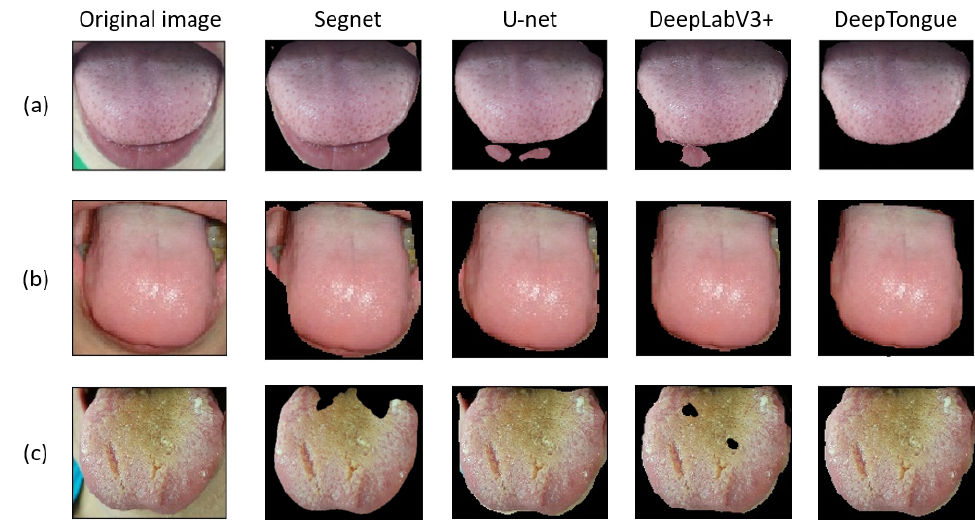
Figure 8. Visual results of segmentation for tongue images. ( a ) the segmentation of the tongue which is severely affected by the lips, ( b ) the segmentation of the tongue which is severely affected by the lips and teeth and ( c ) the tongue is covered with a layer of green tongue fur, resulting in an abnormal